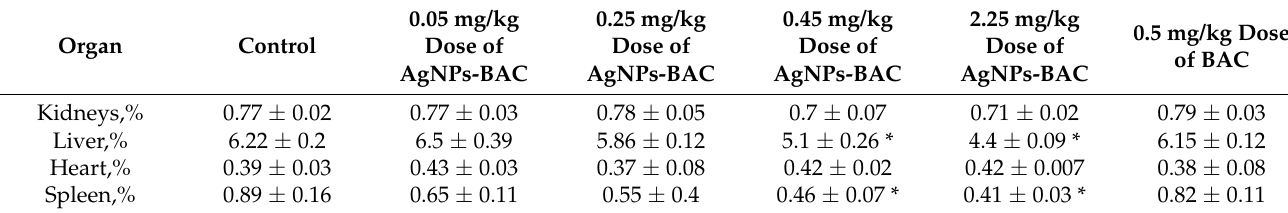
Table 5. The mass coefficients of the internal mice organs upon multiple intragastric administration of the studied substances (M ± m, g).